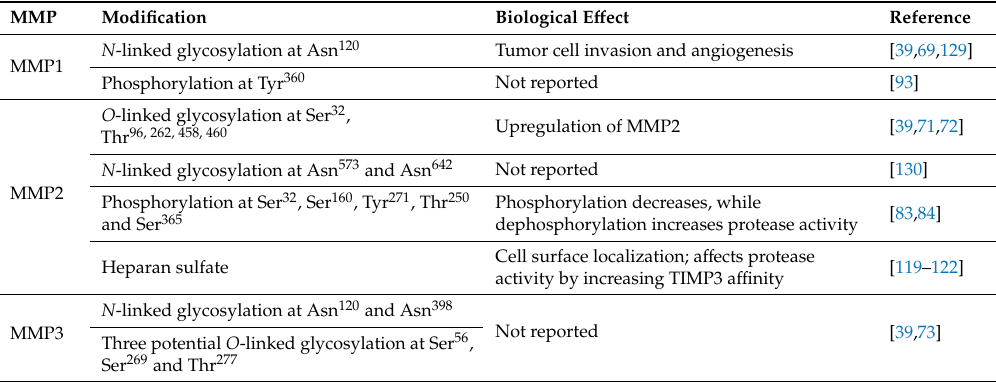
Table 1. List of identified PTMs in